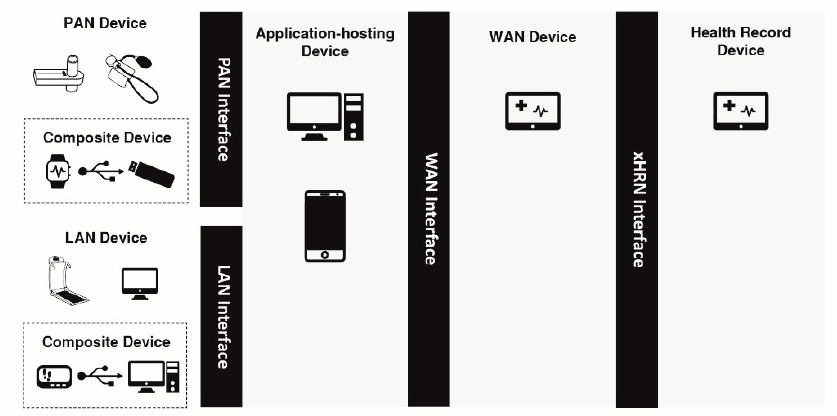
Figure 9. The Continua end-to-end reference architecture (Adapted from Carroll et al. [52]).